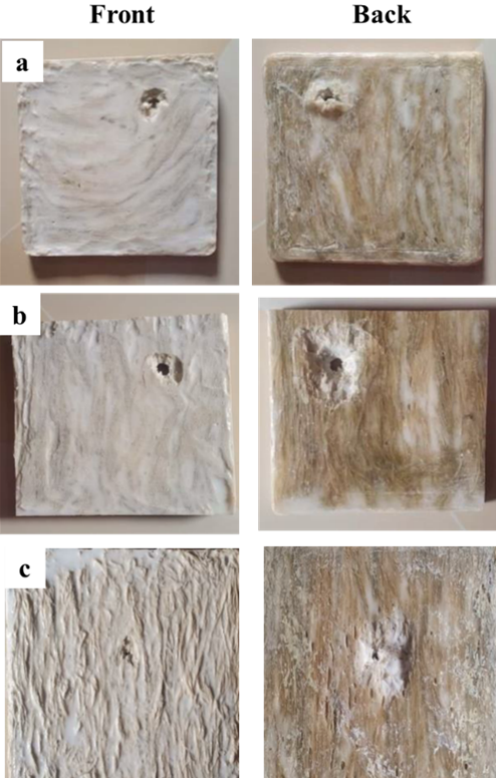
Figure 1. Ballistic Testing Results (a) 10mm Thickness (b) 15mm Thickness (c) 20mm Thickness [5]